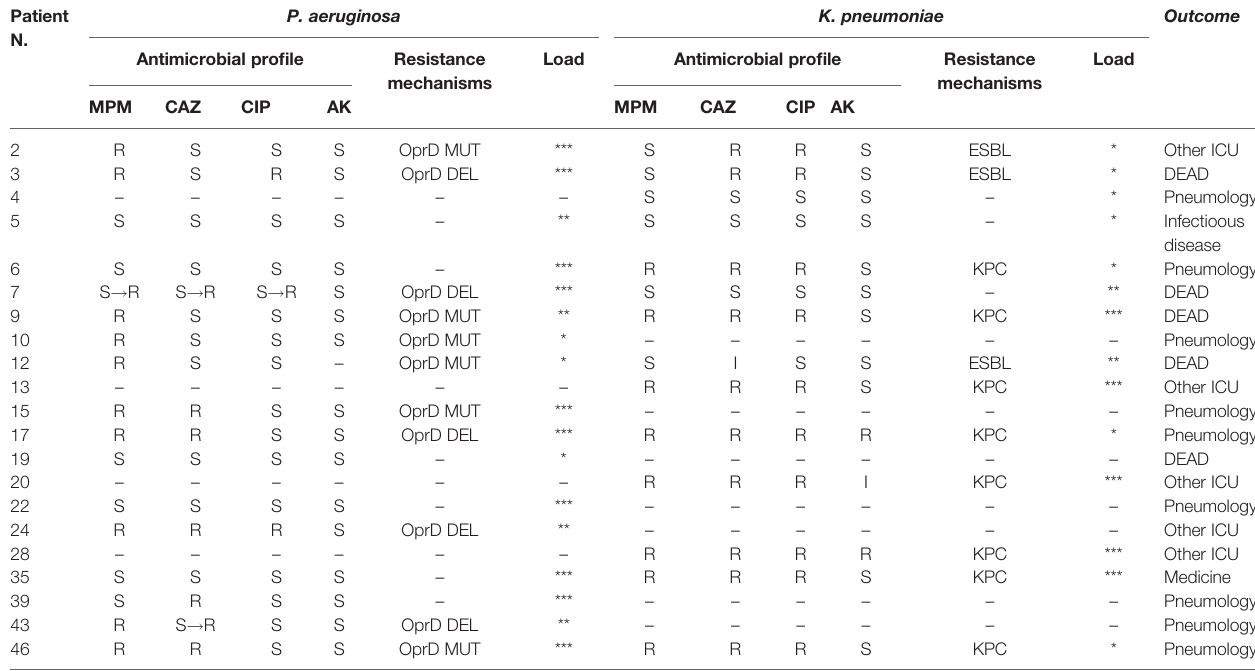
TABLE 2 | Antimicrobial pro fi le, mechanisms of resistance, and load of the two main pathogens recovered in superinfected patients. Patient